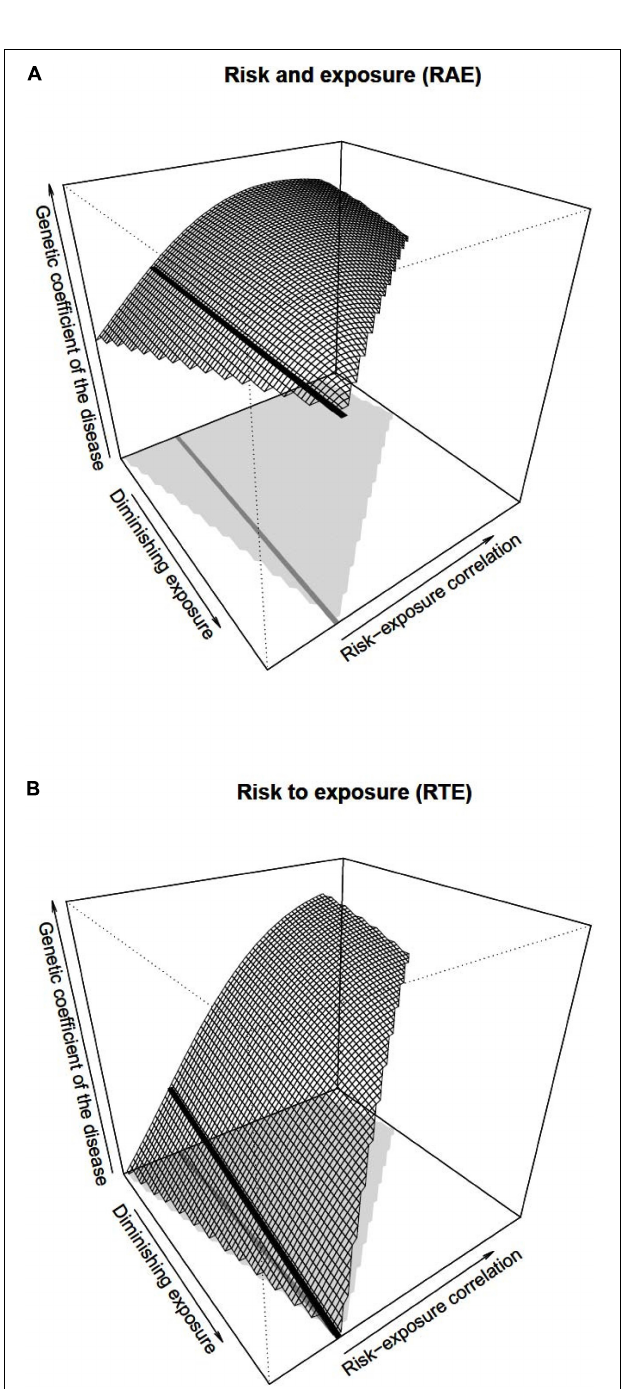
FIGURE 2 | Genetic coefficient of the disease obtained with ARNOIA for the RAE and RTE cases, shown in panels (A) and (B) , respectively. The details of panels (A) and (B) of Figure 1 apply to panels (A) and (B) of Figure 2 , respectively. The range of possible risk-exposure correlations is shown by the light gray area at the bottom of each graph. The values of the vertical axis range from 0 to 1.20. The thick black line (whose projection at the bottom of the figure is shown in dark gray) marks the absence of correlation between risk allele and environmental exposure, which are the ones the former NOIA setting would provide for the whole range of correlations between the risk allele and environmental